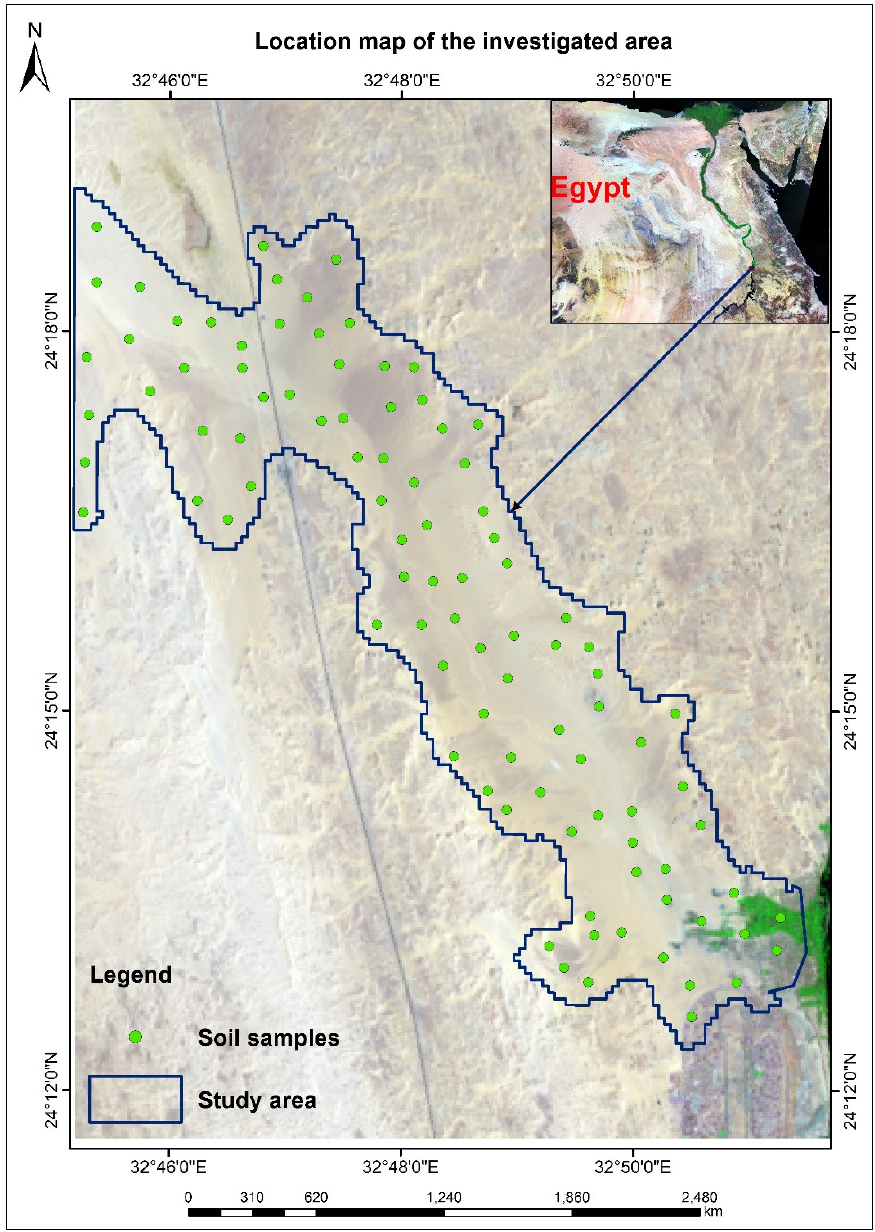
Figure 1. Location maps of the investigated area (Landsat-8, 2022).